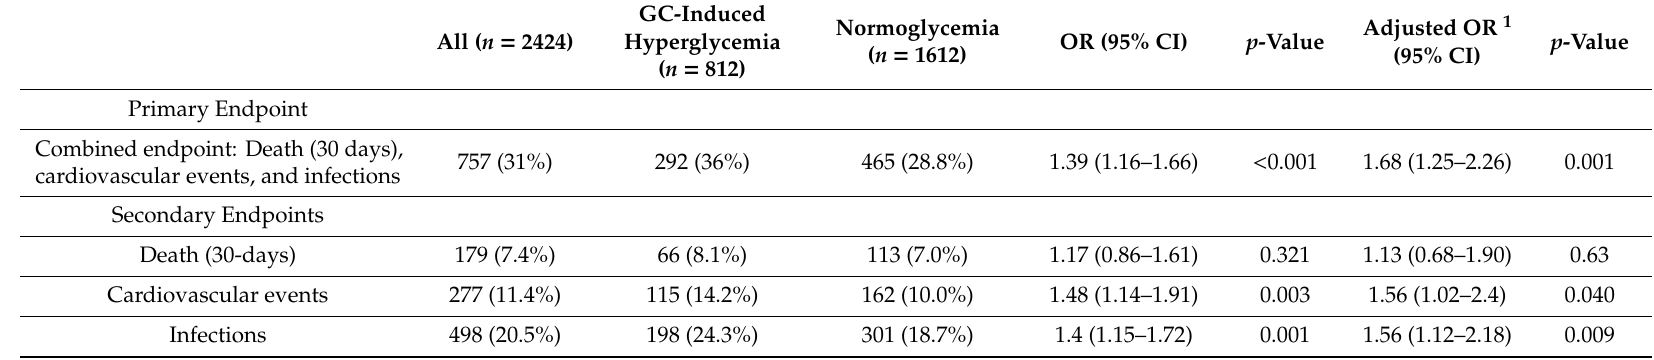
Table 3. Main results of primary and secondary endpoints in patients with and without